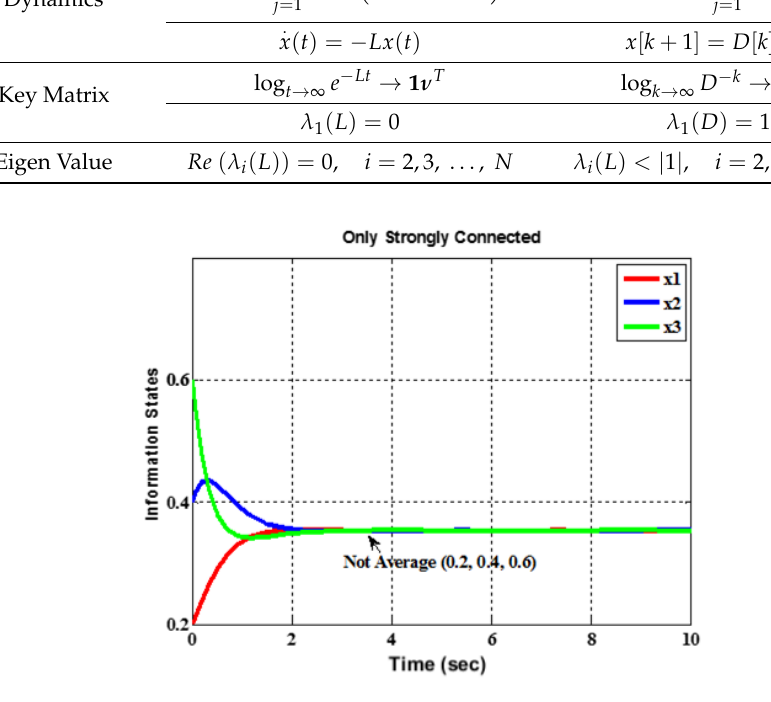
Figure 1. Strongly Connected: Consensus.